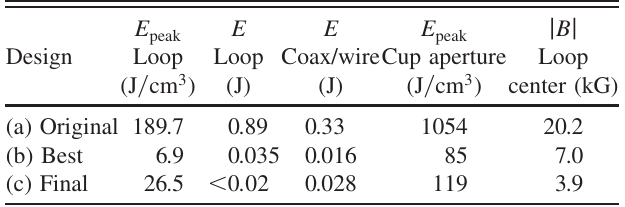
of simulation results for the